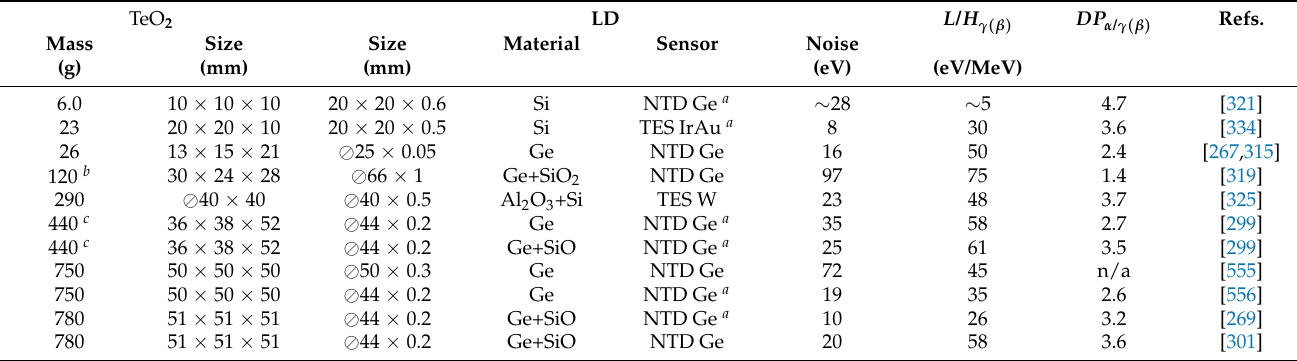
Table 7. Results of low-temperature scintillation and Cherenkov radiation detection with scintillating bolometers based on natural/ 130 Te-enriched TeO 2 crystals and thin LDs. The mass (two significant digits) and the size of the sample, the size, the material (including coating), the sensor technology, and the baseline noise RMS of the coupled LD, as well as the L / H γ ( β ) value and the achieved DP α / γ ( β ) at the 130 Te 0 ν DBD ROI are listed. TeO 2 LD L / H γ ( β ) DP α / γ ( β )